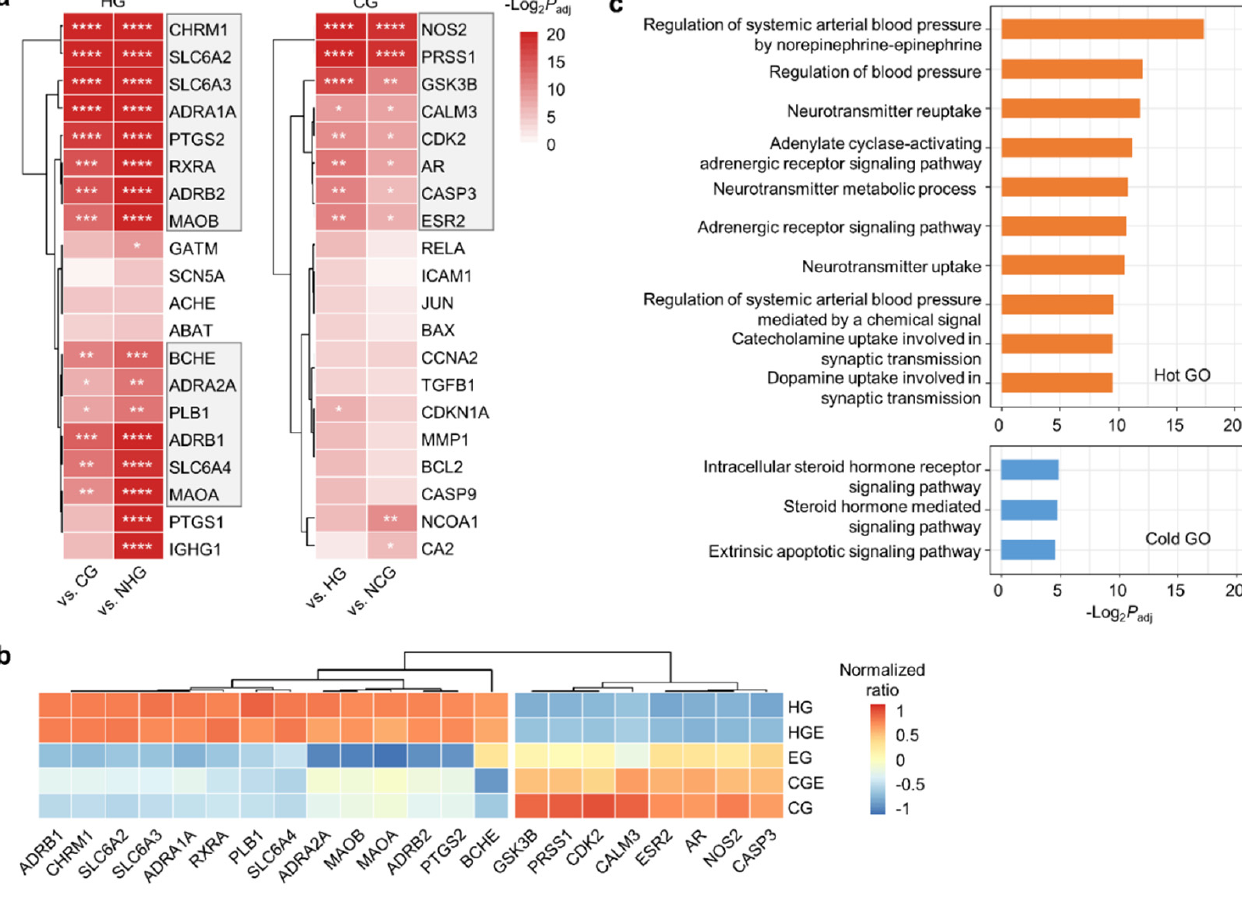
Figure 3. Enriched target genes of herbs in the hot and cold groups. ( a ) Enrichment analysis comparing the target genes of the HG with those of the CG and NHG (left) as well as comparing the target genes of the CG with those of the HG and NCG (right). The p adj values were obtained by Benjamini–Hochberg multiple testing correction after hypergeometric tests. The hot- and cold-specific target genes are denoted with the gray boxes. * p adj < 10 − 2 , ** p adj < 10 − 3 , *** p adj < 10 − 4 , **** p adj < 10 − 5 . ( b ) Normalized ratios of the top five hot- or cold-specific target genes of the herbs of the CG, CGE, EG, HE, and HG, calculated as z-scores. ( c ) Pathway enrichment analysis of the target genes of the HG (upper panel) and CG (lower panel) using g:Profiler with the GO BP gene set. The top 10 functional characteristics were plotted, with p adj <